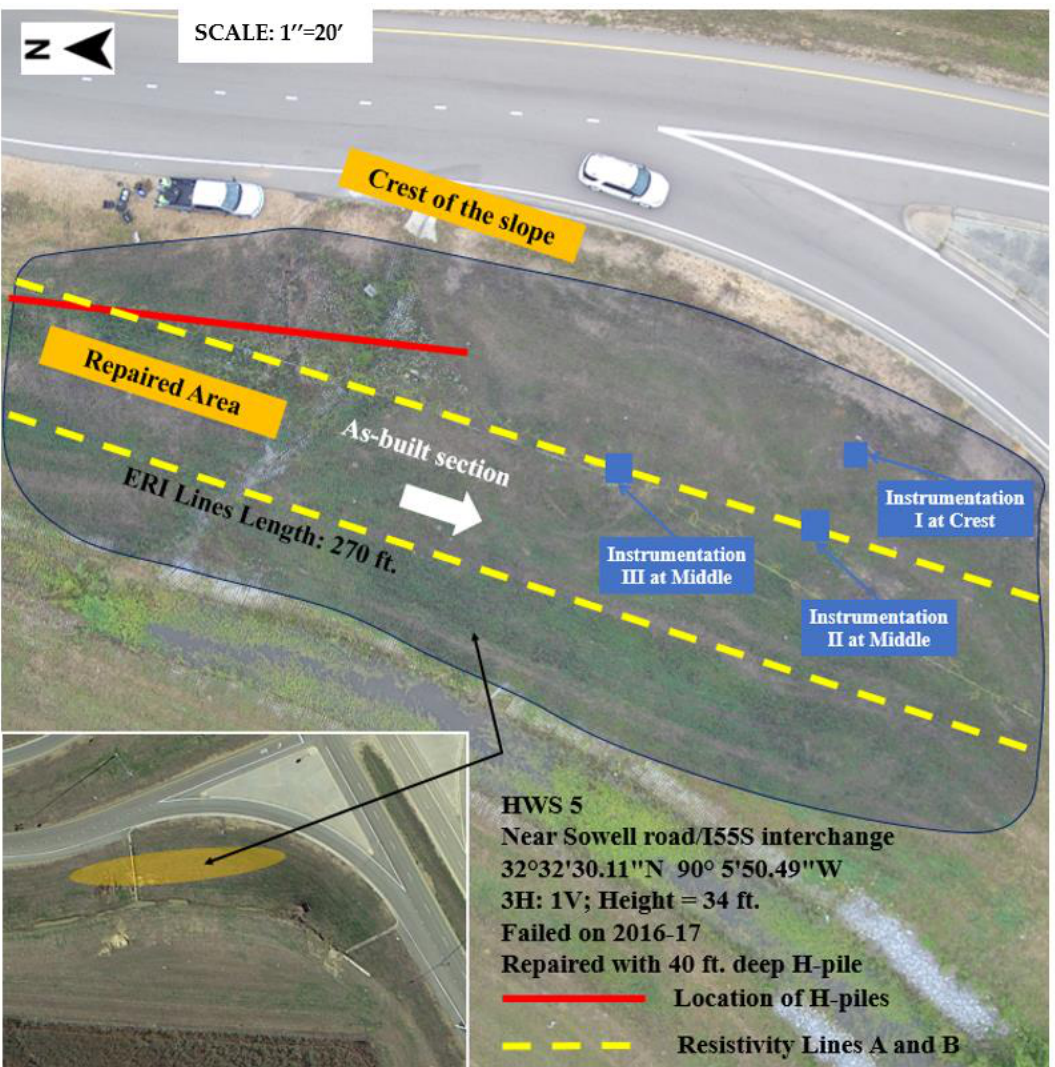
Figure 24. HWS 5 ERI and instrumentation layouts along with its characteristics (drone image-top view) ( 1′ = 1 ft = 0.305